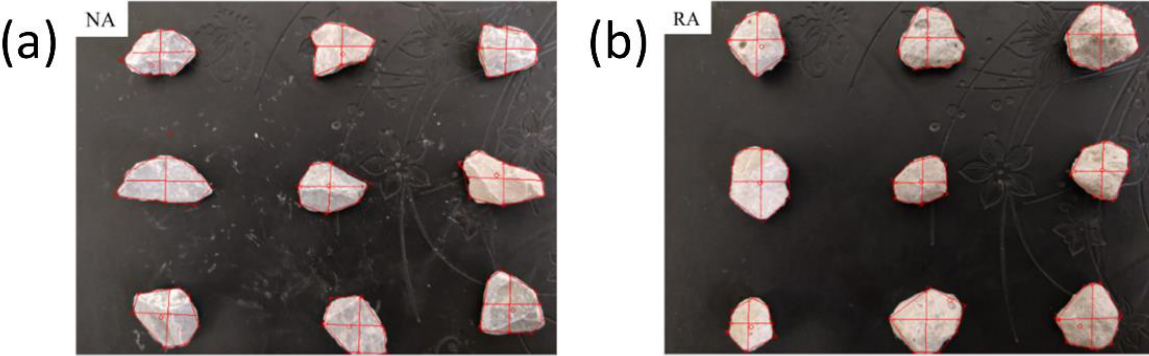
Figure 5. Image analysis of natural aggregate ( a ) and recycled aggregate ( b ).